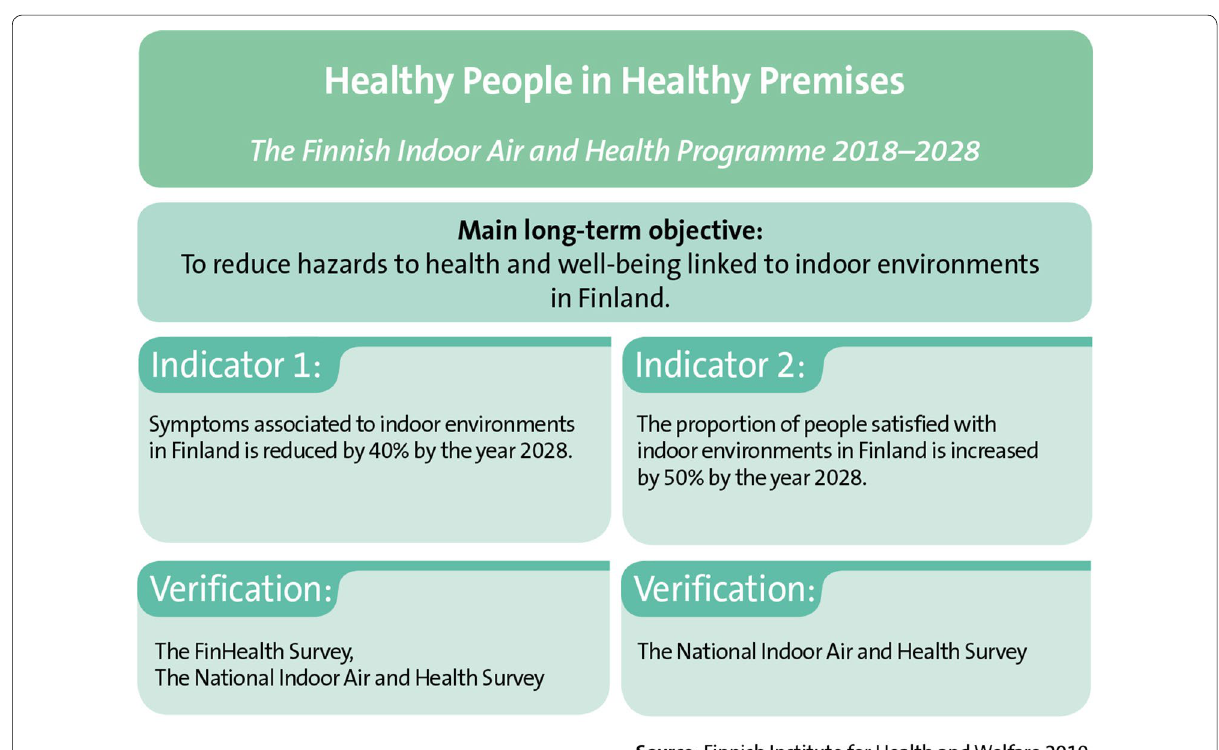
Fig. 4 The primary long‑term objective of the Finnish Indoor Air and Health